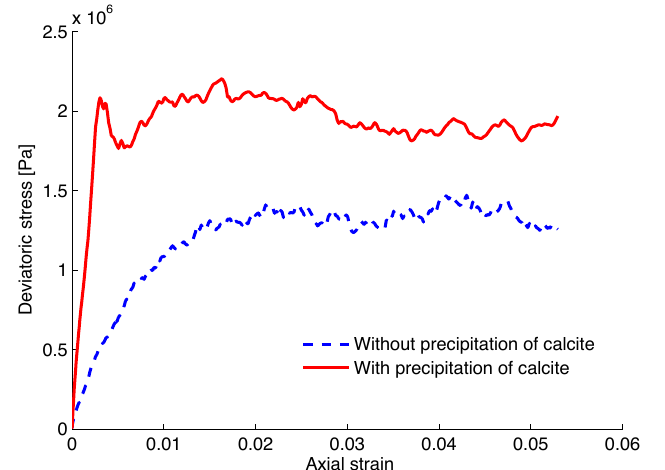
Figure 6. DEM simulation of shear response for bio-treated and untreated sands at a confining pressure of 100 kPa.